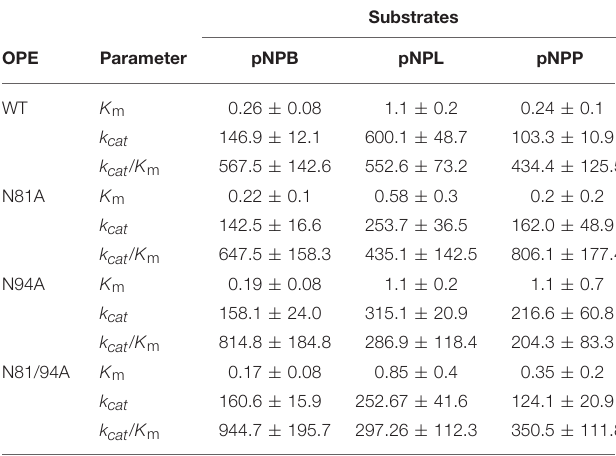
TABLE 2 | Kinetic parameters of the different OPE variants obtained in this work, calculated for pNPB, pNPL and